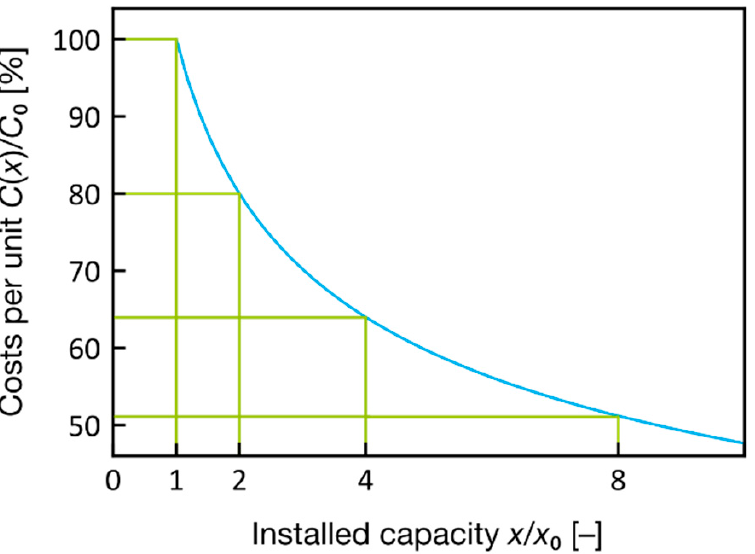
Figure 1. Conceptual illustration of a standard one-factor learning curve. As for Wright’s airplanes, we assume a learning rate LR = 20%. The blue curve shows how the unit cost decreases as a function of installed capacity, while the green lines emphasize that the cost C is reduced by 20% after successive doublings of capacity x .